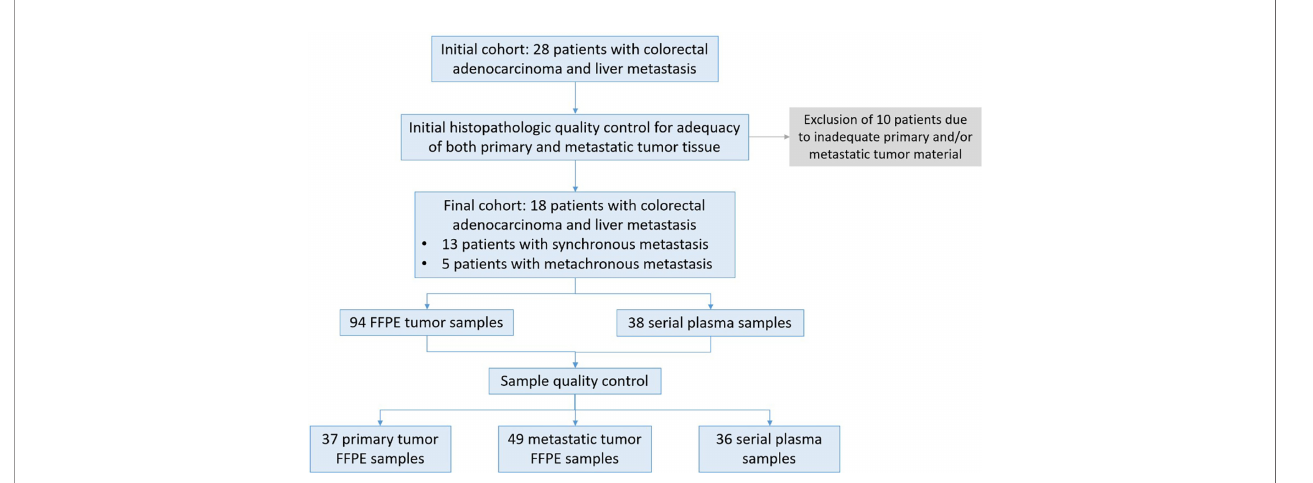
FIGURE 1 | Description of patient samples. Twenty-eight patients diagnosed with colorectal cancer and liver metastasis were enrolled in the study. After initial histopathologic quality control for adequacy of tumor tissue 18 patients were subjected to further analysis. For 16 patients both FFPE tissue as well as blood samples were collected at different time points from diagnosis, before and after surgery and during treatment and monitoring. For two patients FFPE samples were available from different sites of the primary and metastatic site. A total of 122 samples passed QC requirements (92.4%) for NGS analysis.